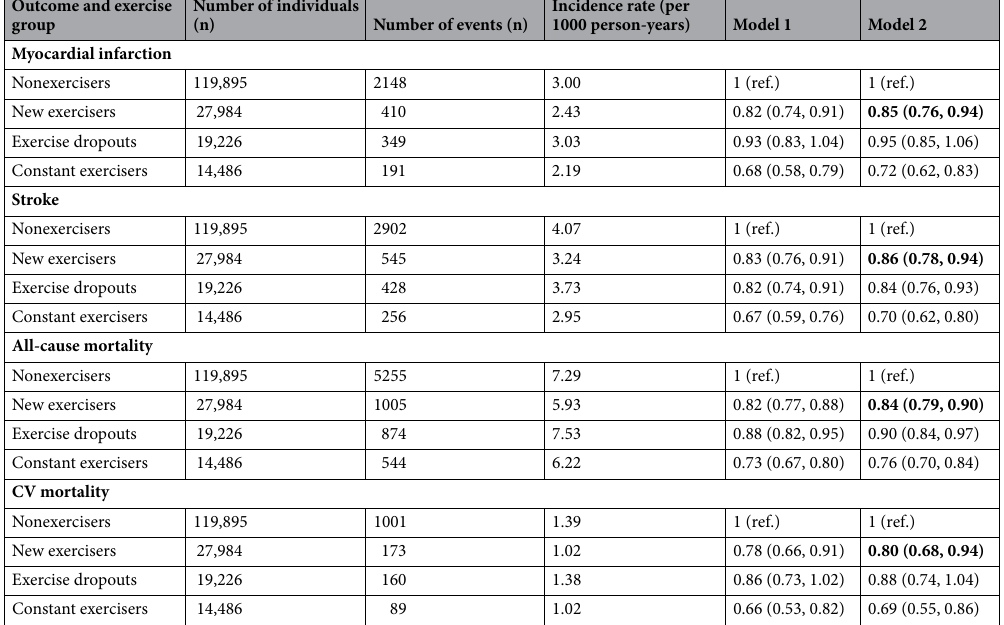
Table 2. Hazard ratios with 95% confidence intervals for myocardial infarction, stroke, and all-cause or cardiovascular (CV) mortality according to the change in exercise status. Model 1; adjusted for age, sex, body mass index, income status, hypertension, dyslipidemia, fasting blood glucose, kidney function, use of insulin, and number of oral hypoglycemic agents. Model 2; model 1 + adjusted for alcohol intake and smoking status.